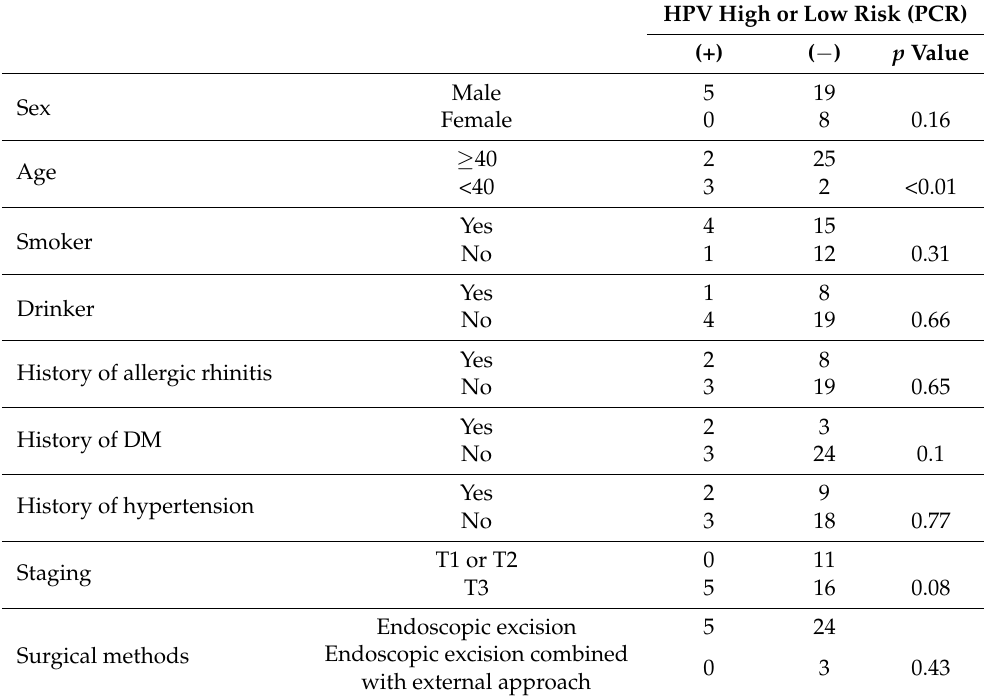
Table 2. Association Between HPV Infection and Clinical Characteristics in Patients with Sinonasal Inverted